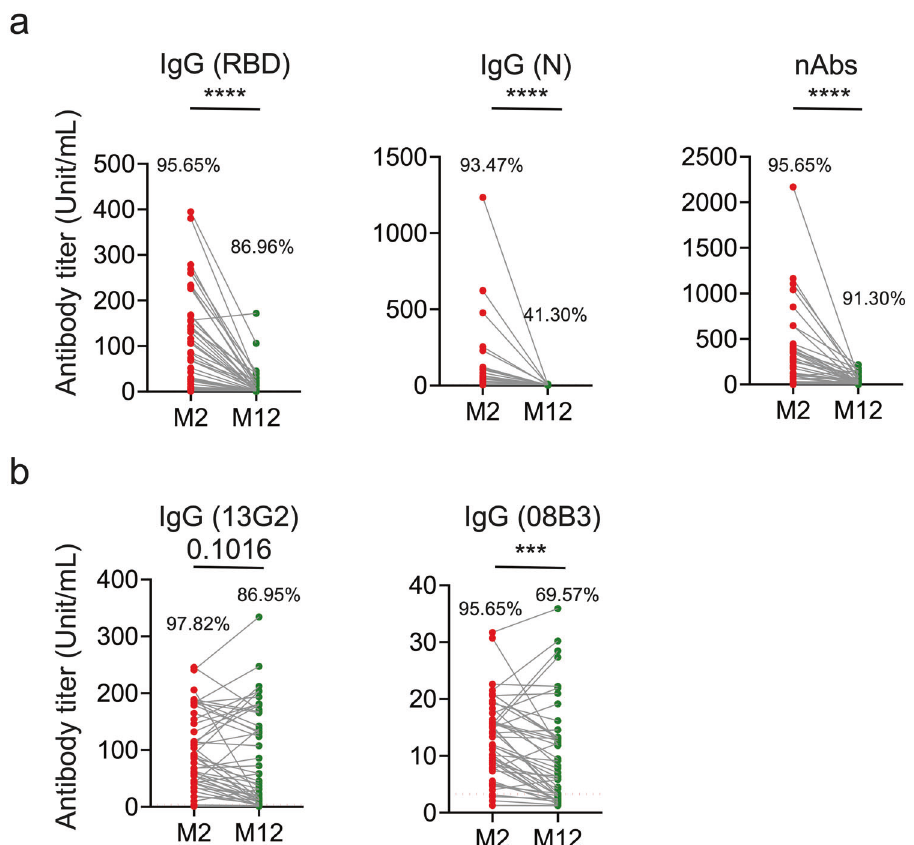
Fig. 1 Neutralizing antibodies show a slower decay rate than binding antibodies. Two blood samples were collected from convalescent individuals with COVID-19 at approximately 2 (M2) and 12 months (M12) after disease onset ( n = 46). The antibody levels at M2 and M12 were measured ( n = 46). Total IgG to RBD and N in the plasma samples were examined using ELISA, and nAb levels were examined using the focus reduction neutralization test (FRNT 50 ). a Pair comparisons of IgG to RBD, N, and nAbs between M2 and M12. b Pair comparisons of antibody levels to 13G2 and 08B3 clusters. Each dot represents an individual participant. *** p < 0.001 and **** p < 0.0001. Wilcoxon rank-sum test was used to compare paired continuous variables that were not normally distributed. The percentage above the dot plots indicates the detection rate of each group. We also estimated the average antibody decay rate by fi tting the longitudinal data from the 46 patients to an exponential decay model using a Bayesian hierarchical framework (detailed in Materials and Methods). The key outputs of the model fi tting including the distribution of the mean decay rate and the associated half-lives of the different antibody populations are listed in Table 1. The decay rate of anti-RBD IgG (median 0.249, 95% CI: 0.21 – 0.287), anti-N IgG (median 0.35, 95% CI: 0.298 – 0.414), Table 1. Two neutralizing antibodies clusters, represented by clones 13G2 and 08B3, show minimal decay To assess the wide range and durability of SARS-CoV-2-speci fi c neutralizing antibodies, a competitive ELISA assay was established using two neutralizing monoclonal antibody clones, 13G2 and 08B3. These monoclonal antibodies were harvested from the ascites of mice injected with two hybridoma cell lines generated from mice immunized with the SARS-CoV-2 RBD. Clone 13G2 had been shown to neutralize both the wild-type SARS-CoV-2 and Beta variants, whereas clone 08B3 was shown to neutralize the wild- type but not Beta variants (unpublished data). Competitive ELISA was performed to measure the levels of two nAb clusters targeted or shared with the epitopes of two nAb clones, 13G2 and 08B3, in sera of 46 individuals who had recovered from COVID-19. As shown in Fig. 1b, the percentages of Signal Transduction and Targeted Therapy (2022)